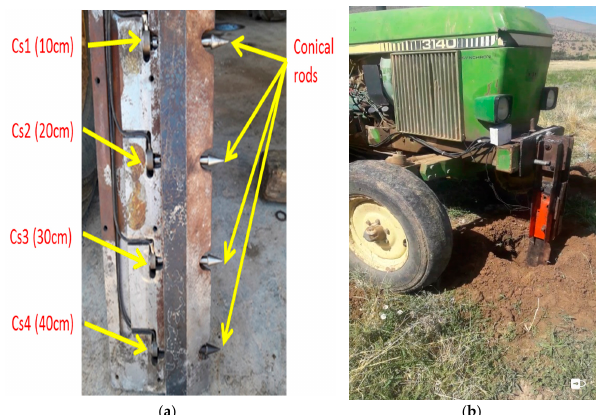
Figure 4. ( a ) Loadcells and conic bars of pressure mounted on the blade, ( b ) the blade’s position at the front of the tractor. 2.5. Design and Fabrication of the Hydraulic System The height of the tractor arms was controlled by a hydraulic jack which is attached to the tractor by a separate base at one end and to a support rod mounted on the lower arms of the tractor at the other end (Figure 5a).